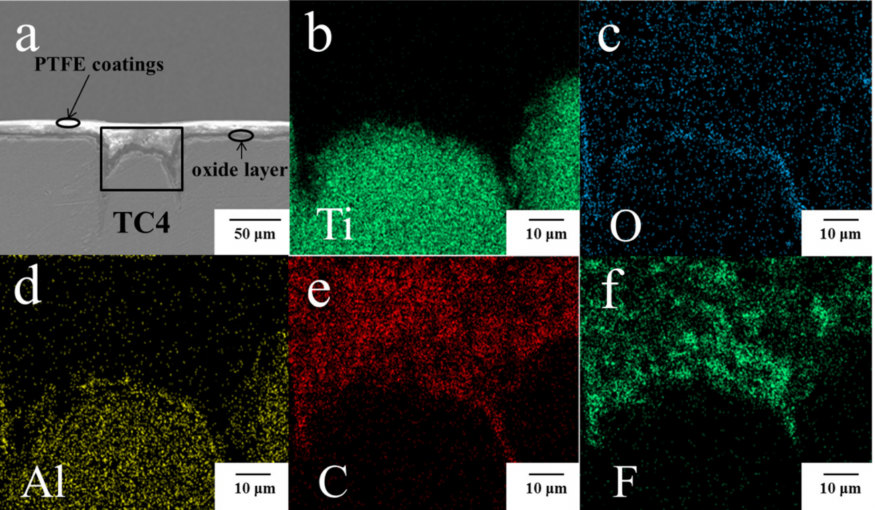
Figure 3. The cross-section ( a ) and corresponding EDS mappings ( b – f ) of the composite